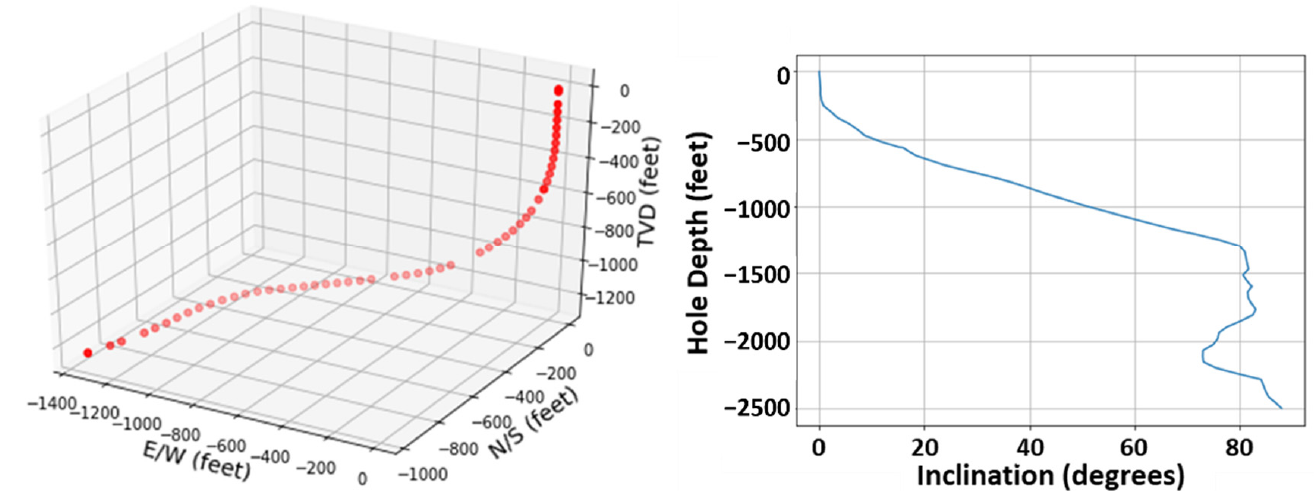
Figure 11. Well trajectory and inclination profile (negative sign indicates downward depth into the sub-surface).